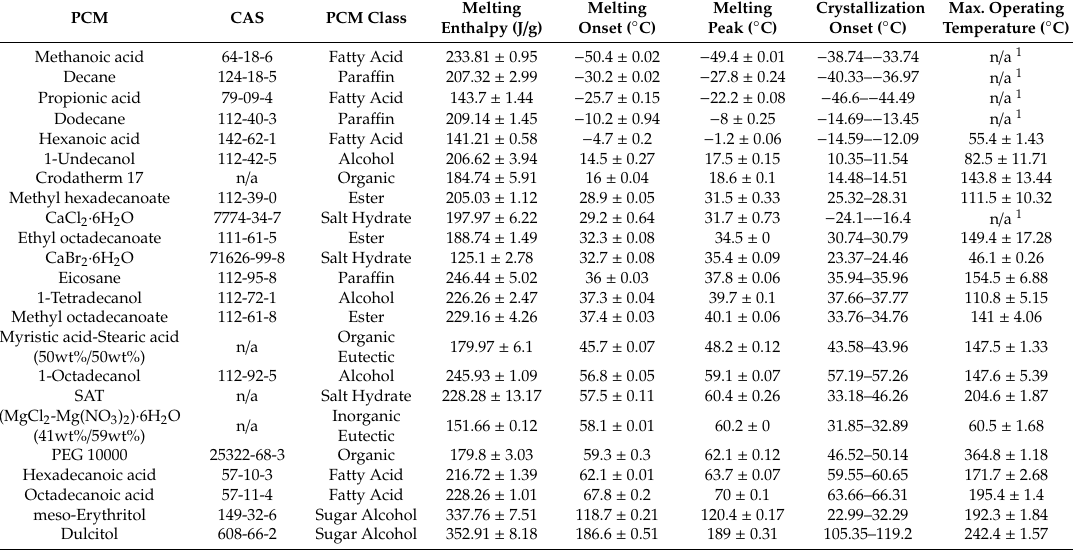
Table 5. Overview of the properties for all the PCM measured in this work. Given are the mean ± standard deviation or the range of crystallization onset temperature as minimum and maximum measured